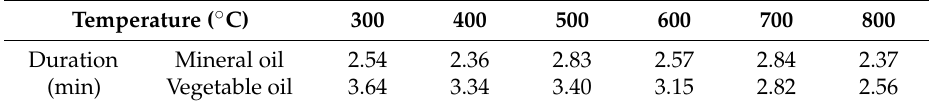
Table 2. Duration of mineral and vegetable oil samples before reaching required temperatures.